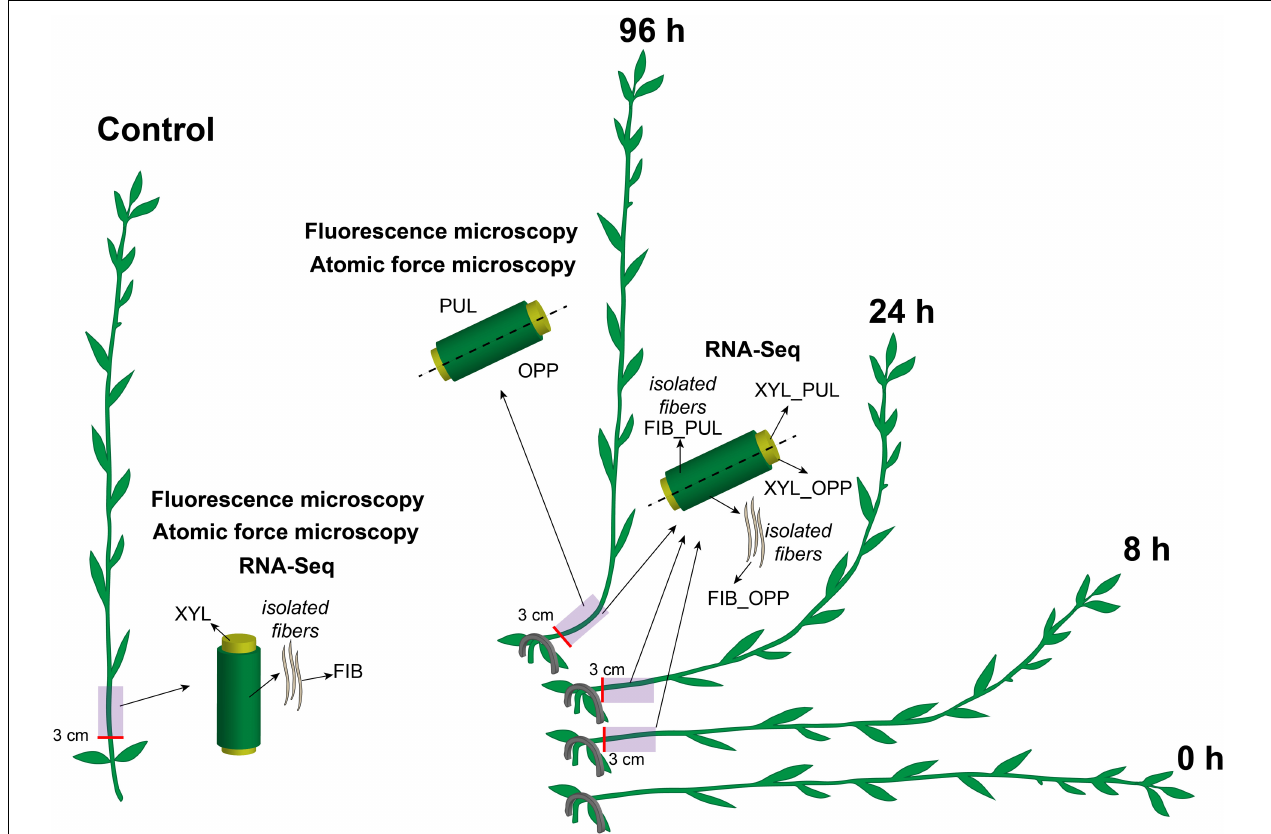
FIGURE 1 | Schematic of the experimental design. Flax plants were inclined and stapled to the soil at the level of the cotyledons. Gravitropic response developed over 96 h. Five-cm-long stem segments beginning at 3 cm above the cotyledons were used in the analyses. The upper part of the gravitropic bend was designated as the pulling side (PUL) and the lower part as the opposite side (OPP). Phloem and xylem (XYL) parts of the stem were collected separately for RNA-Seq in the control and after 8, 24, and 96 h of gravitropic response. Phloem parts were washed several times in ethanol in a mortar with gentle pestling to isolate phloem fibers (FIB). All samples for fluorescence microscopy and atomic force microscopy were collected 96 h after gravistimulation. Control samples were taken from the non-inclined plants, at the same stem level and at the same time as for the inclined